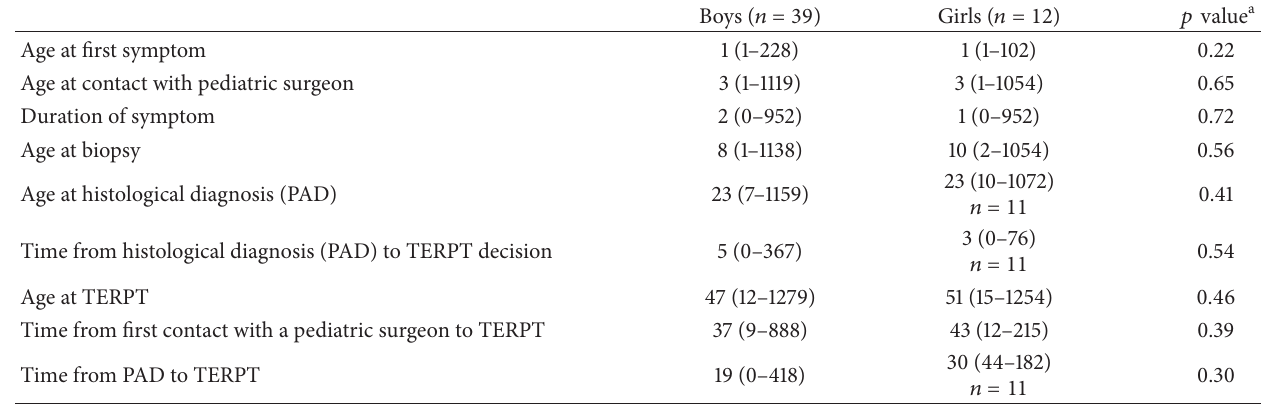
Table 2: Preoperative data presented as median (range) in days. The number of included patients was 39 boys and 12 girls; however information was missing in some of the patients’ journals. PAD refers to Pathological Anatomical